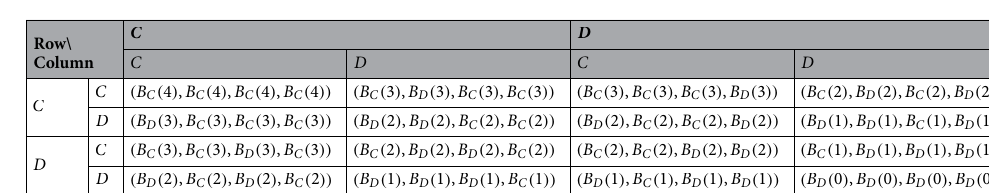
Table 3. Pay-off table of four-player weightlifting game.